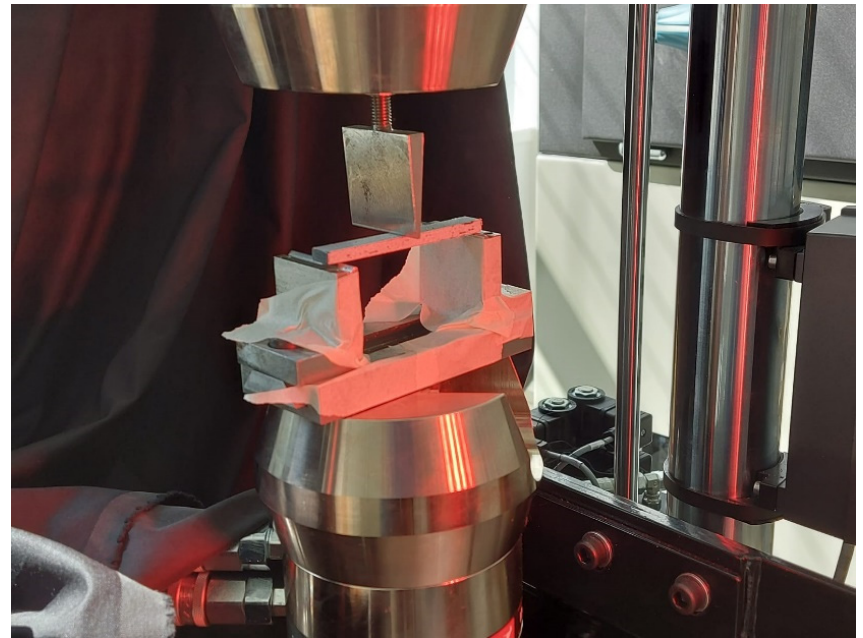
Figure 5. Bending test of multi-ply CFRP.